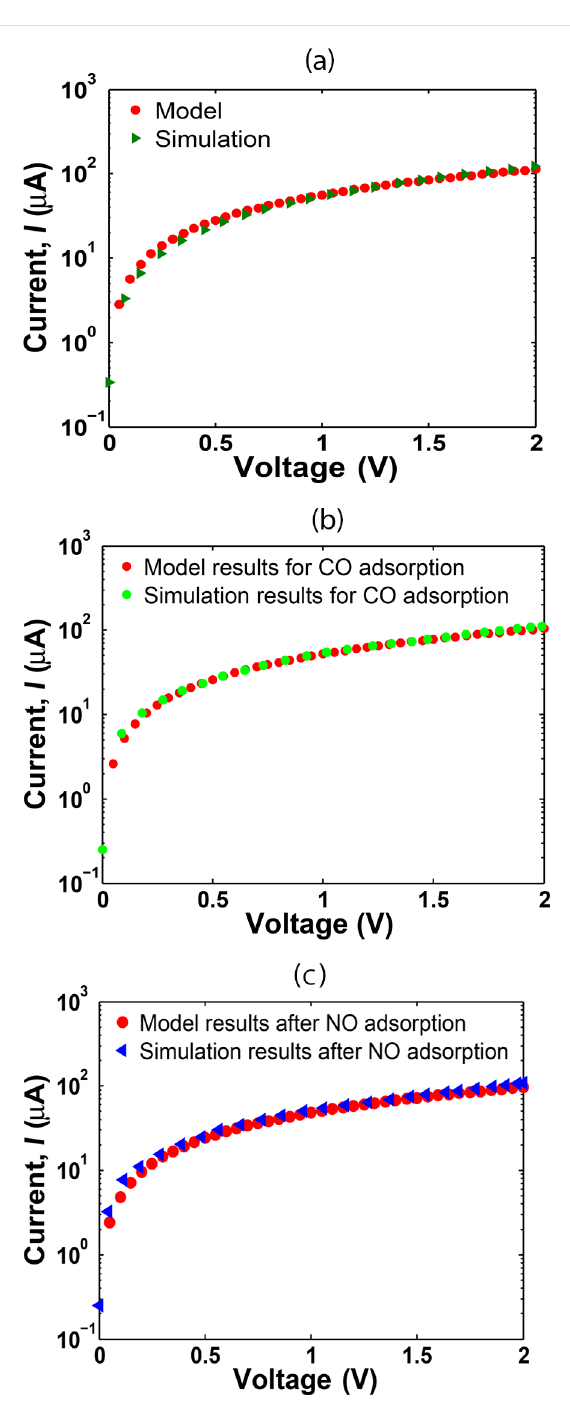
Figure 7: The comparison study for the I – V characteristics of the sensor simulated by MATLAB and the Atomistix Toolkit (ATK): (a) bare system, (b) after CO adsorption, and (c) after NO adsorption.